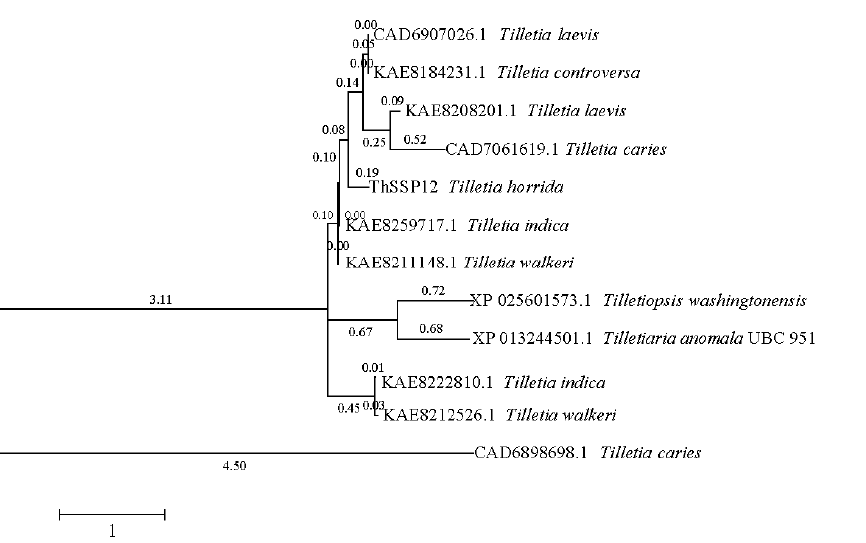
Figure 1. Putative effectors in Tilletia horrida induce cell death in Nicotiana benthamiana leaves. ThSCSP_12 induced cell death in N. benthamiana , whereas three other proteins did not. Green fluorescent protein (GFP) served as a negative control. BAX was the positive control. Numbers e.g., 30/30, indicate that 30 of 30 infiltrated leaves exhibiting cell-death or mottling phenotypes. Representative photos were taken at 4 days post-inoculation (dpi).